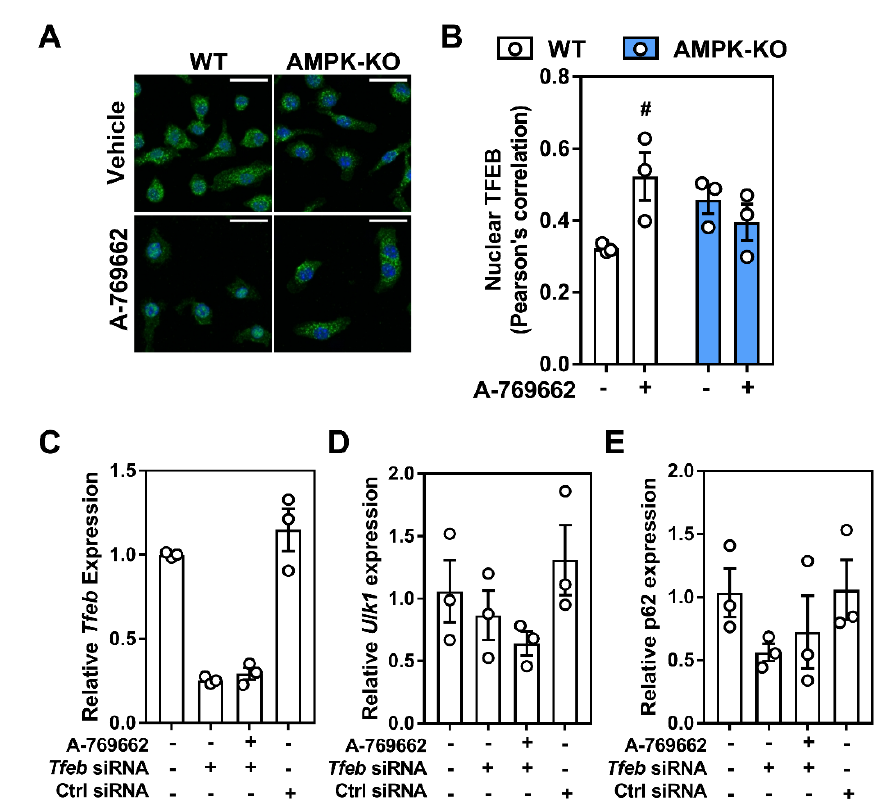
Figure 7. Macrophage AMPK activation regulates lysosomal-associated gene transcription through TFEB regulation. ( A ) Macrophages were treated for 2 h with A-769662 (100 µM). Shown is a representative immunofluorescent image z-projection for maximum intensity, scale bar is 25 µm (TFEB; Green, DAPI; Blue). ( B ) Pearson’s correlation coefficient for the co-localization of TFEB and DAPI across all z-stacks from ( A ), where 1 represents 100% co-localization and 0 represents 100% no co-localization. Macrophages were incubated with Tfeb or control siRNA followed by AMPK activation with 5 h incubation with A-769662 (100 µM). The transcript expressions of ( C ) Tfeb , ( D ) Ulk1 , and ( E ) Sqstm1 (gene encoding p62). Transcript expression was normalized to the average expression of β-actin and Tbp. Data represent the mean ± SEM, where # represents p < 0.05 between treatments, as calculated by a 2way ANOVA.